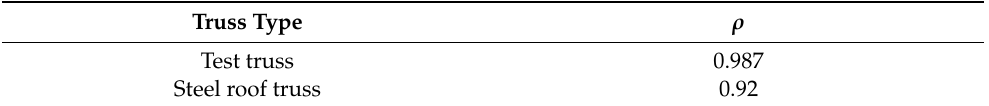
Table 2. Pearson correlation coefficient.